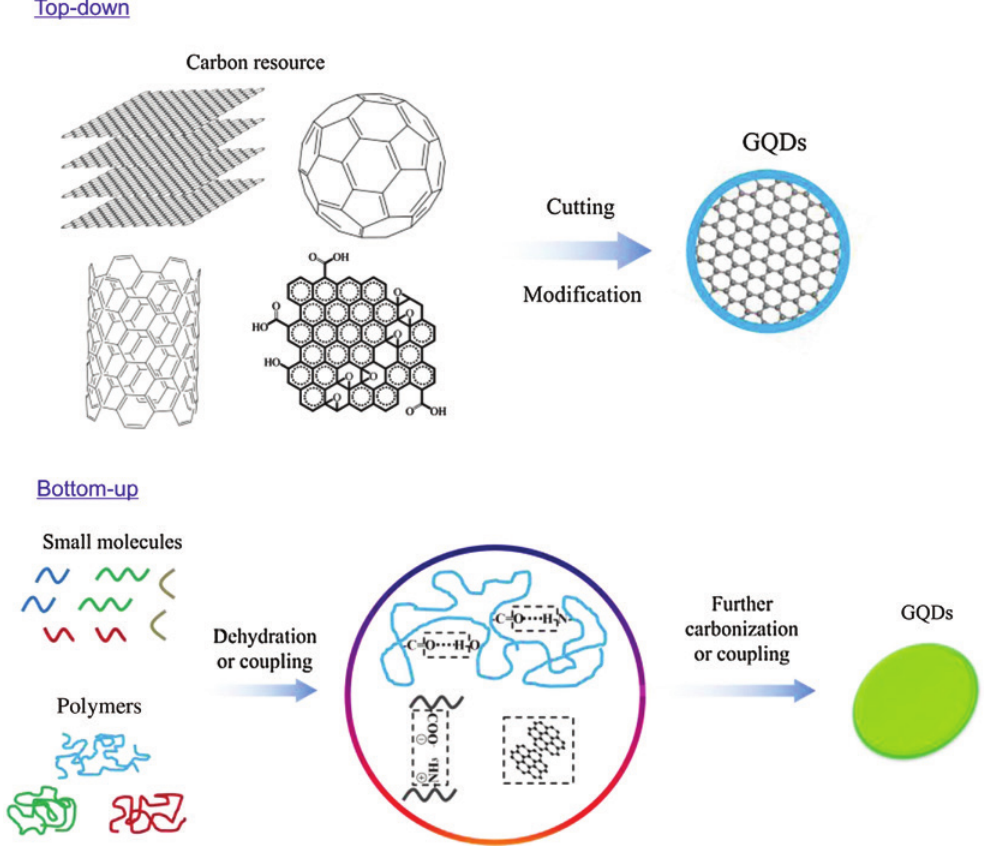
Figure 1: Two main approaches adopted to prepare fluorescent GQDs: the “top-down” splitting route from different carbon sources and “bottom-up” method from small molecules or polymers (reprinted/reproduced with the permission of Ref. [57], copyright 2017, Elsevier